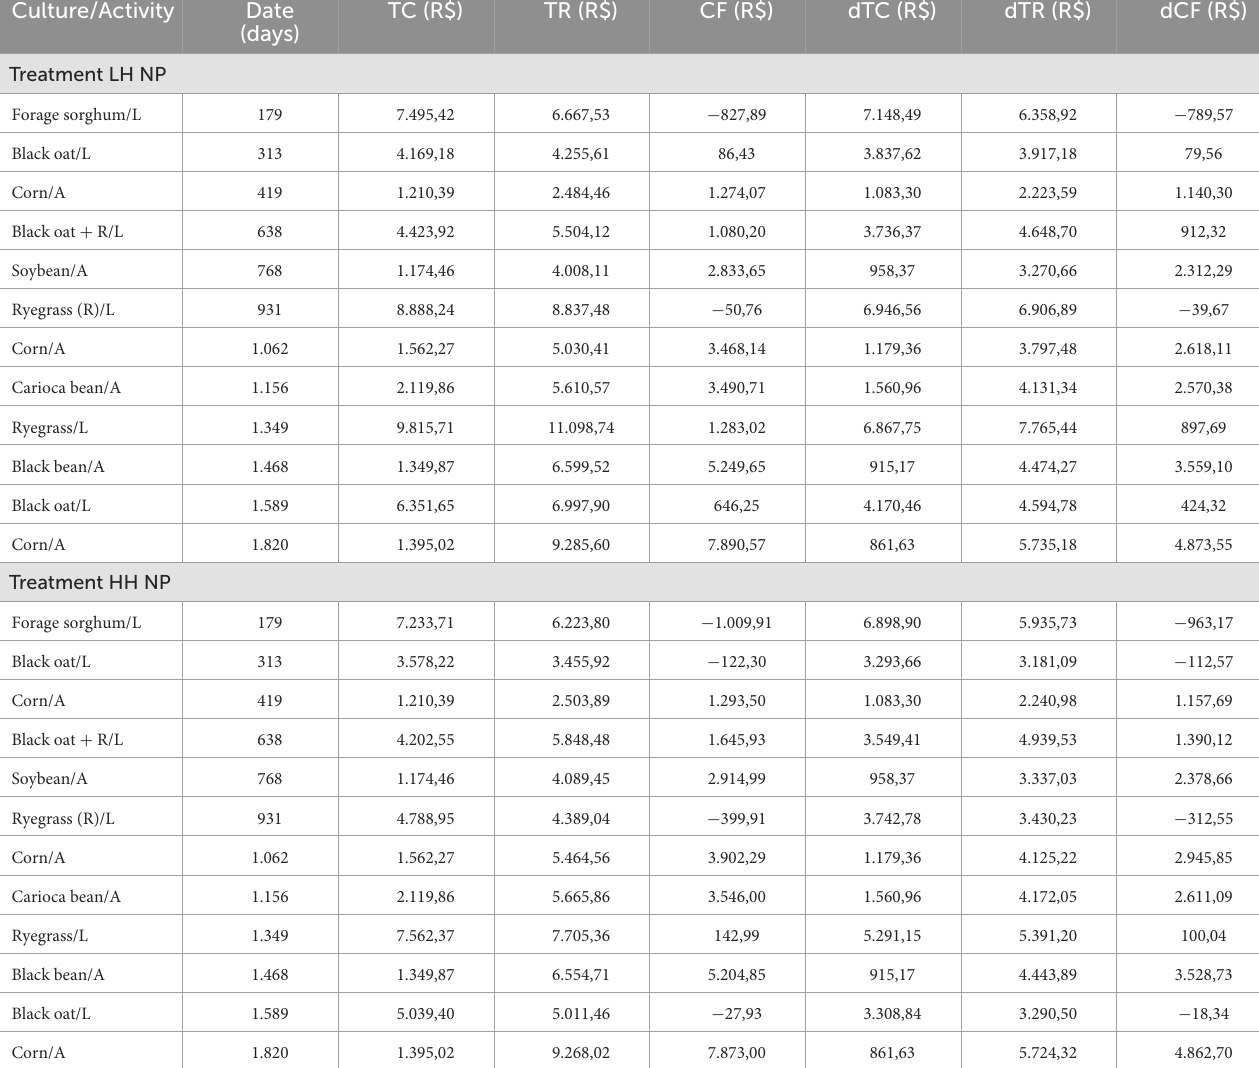
TABLE 5 Total cost (TC), total revenue (RT), and cash flow (FC) for treatments that received nitrogen fertilization in the pasture in the ICLS for 5.5 years.